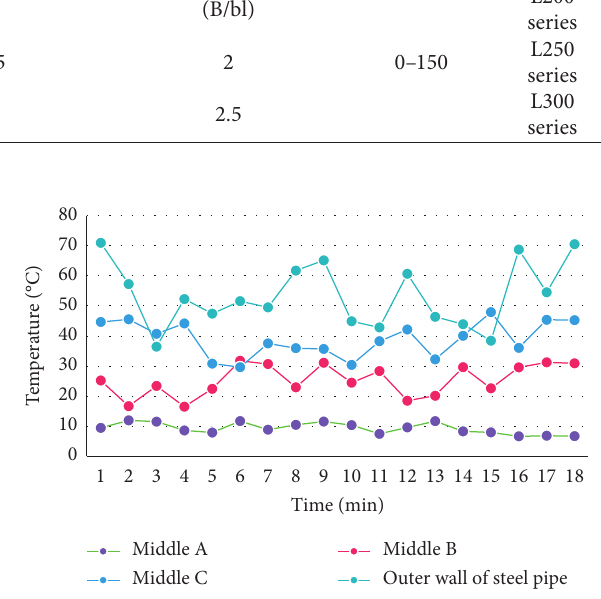
Figure 2: The temperature change trend of each measuring point of the cross-section during the heating stage with time. Table 2: Time for the center point of the specimen to reach the set temperature.